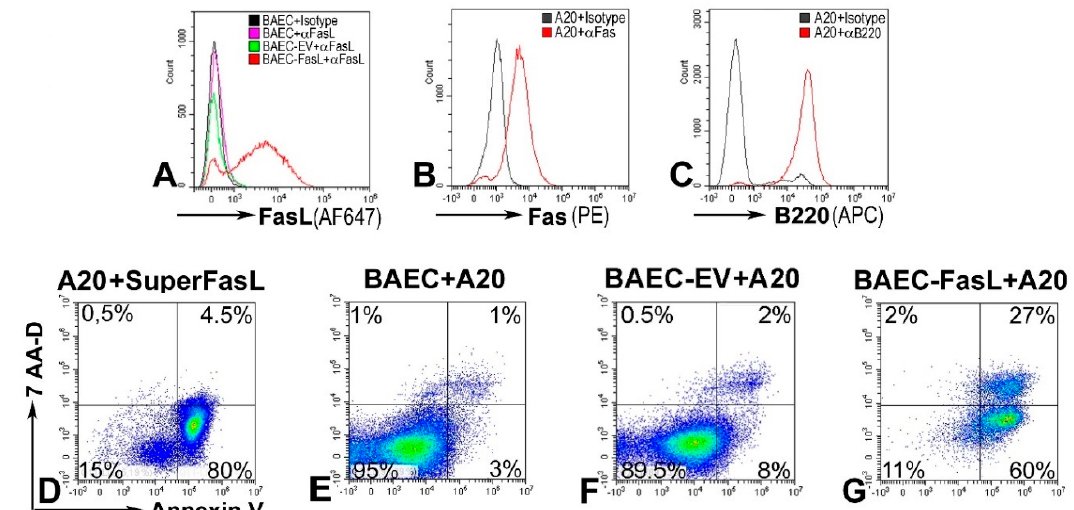
Figure 4. FasL expressed on Ad-gFasL-transduced bovine aortic endothelial cells induces apoptosis of responder cells: ( A ) FasL expression in naïve bovine aortic endothelial cells (BAECs) (pink line), BAECs transduced with an empty virus (EV, green line), and BAECs transduced using Ad-gFasL (red line). ( B ) A20 cells (responder cells) express Fas. ( C ) A20 cells are positive for B220 marker. ( D ) The majority of A20 treated with SuperFasL (trimerized soluble FasL) are apoptotic. ( E ) A20 cells incubated with naïve BAEC are viable. ( F ) BAECs transduced with an empty adenovirus (BAEC-EV) do not induce a significant death of A20 cells. ( G ) By contrast, A20 cells incubated with FasL-expressing BAEC are 87% apoptotic, positive for Annexin V ( F ). In the cell mix, A20 cells were identified based on B220 ( E – G ).